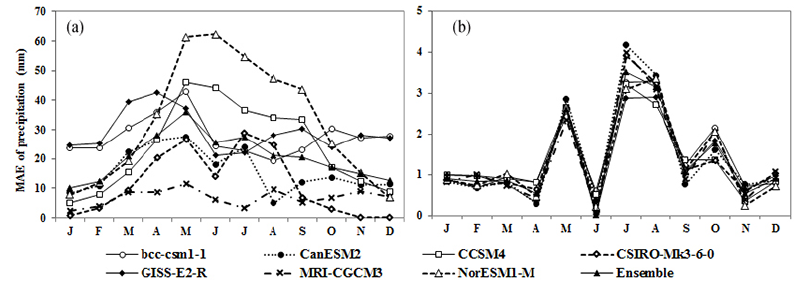
Figure 3. Mean Absolute Error of (a) simulated climatological monthly mean precipitation (mm) by original CMIP5 output and (b) down- scaled models in China from 1950 to 1999.